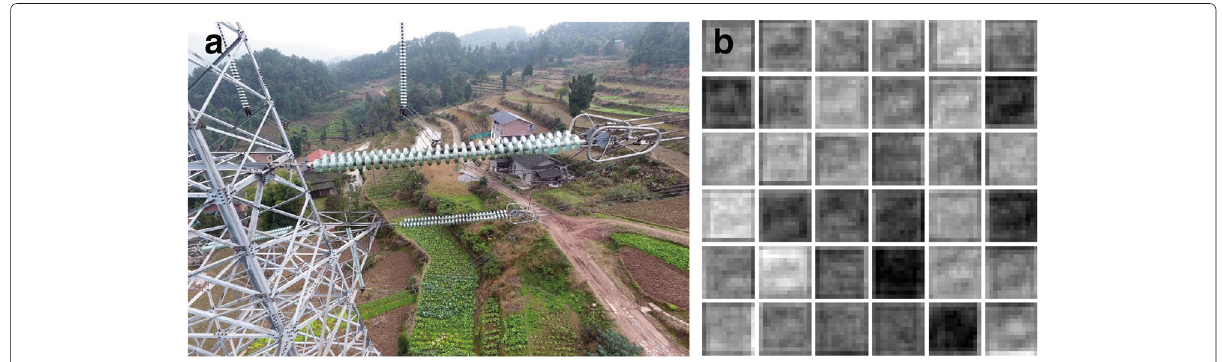
Fig. 6 The original image of insulator and its feature maps